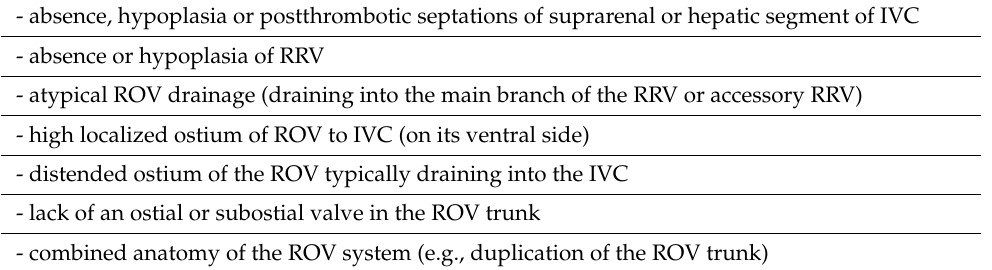
Table 3. The most important anatomical factors correlated to ROV insufficiency.